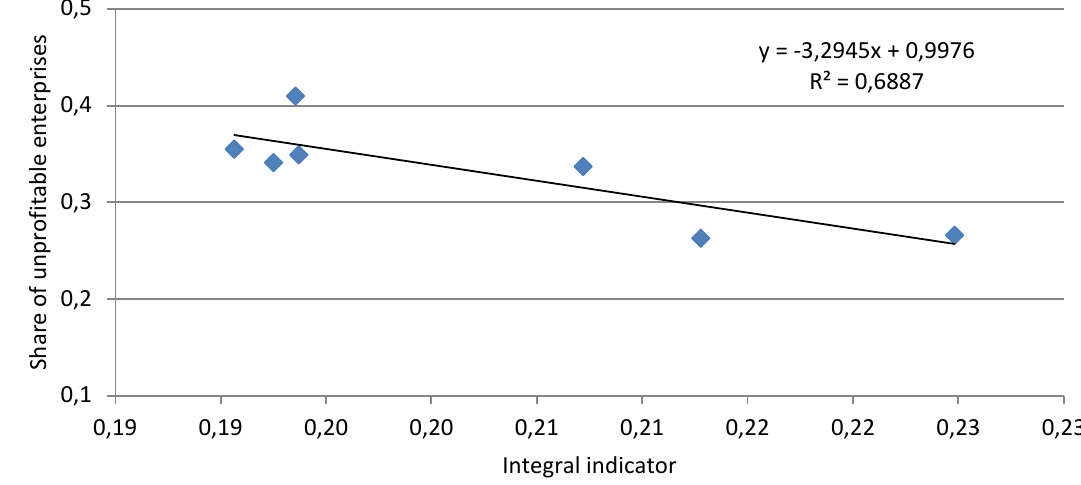
Figure 6. Relationship between the level of business environment security and the share of unprofitable enterprises in